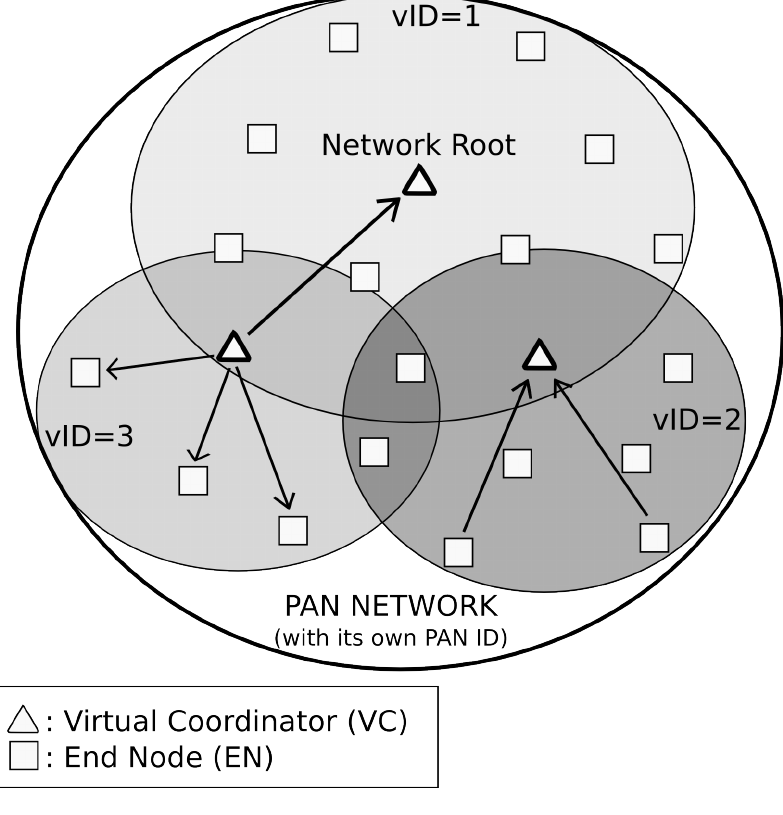
Figure 1. DARAL basic